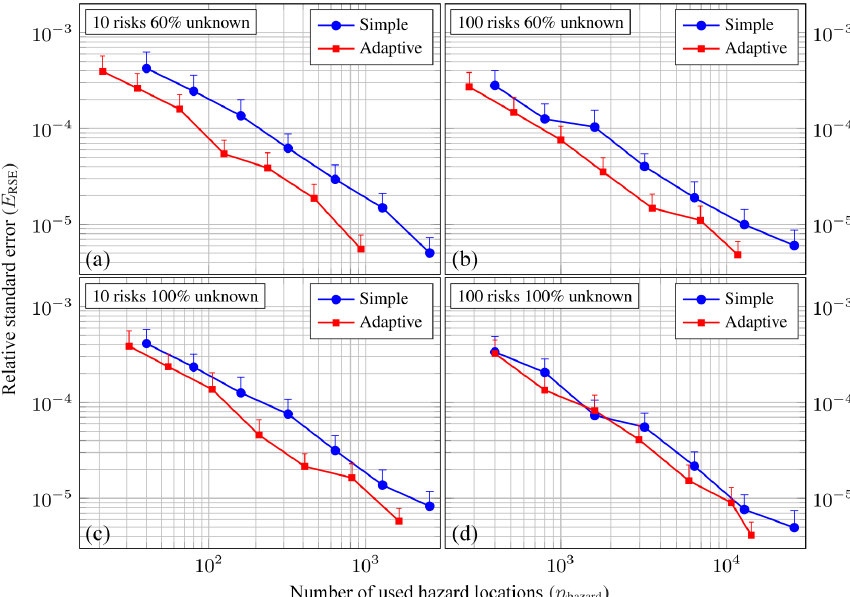
Figure 15. Logarithmic plot of relative standard errors E RSE of probable maximum loss (PML) at a return period of 100 years against the total number of used hazard locations n hazard for different portfolios with n r = 10 (a, c) and n r = 100 (b, d) risk items and 60% (a, b) and 100% (c, d) unknown coordinates. Simple MC is shown in blue, and the adaptive variance reduction scheme is shown in red. All E RSE values have been obtained from R = 20 repeated simulations; vertical error bars depict upper 95% confidence intervals estimated using bootstrapping with 1000 resamples. Table 3. Mean run time speedup and standard errors ( S ± E SE ) of the hazard computation achieved by the adaptive location uncertainty sampling scheme in comparison to simple sampling to obtain relative standard error levels of ε RSE = 10 − 4 and ε RSE = 10 − 5 , estimated from R = 20 repeated simulations. Depending on the portfolio and ε RSE , the mean speedup ranges from 6% to 37%. Speedup ( S )